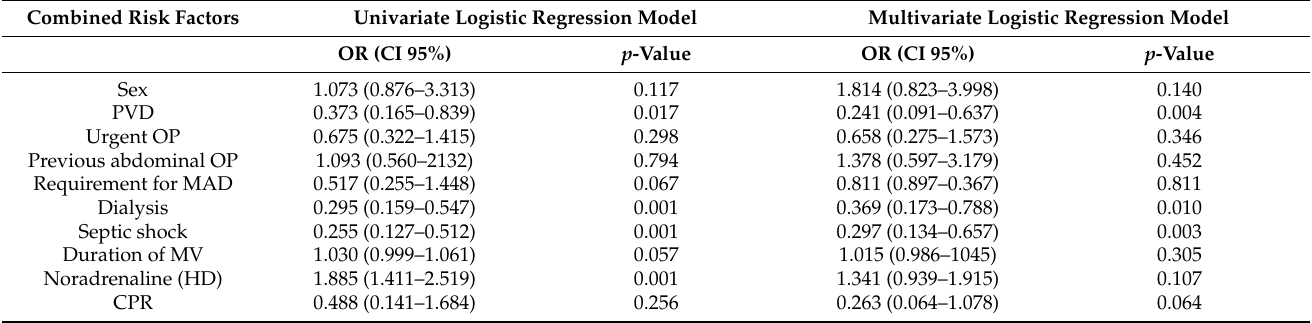
Table 5. Univariate and multivariate logistic regression models of in-hospital